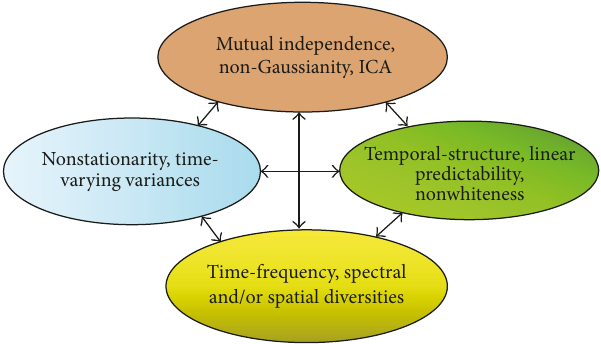
Figure 4: Basic approaches for Blind Sources Separation